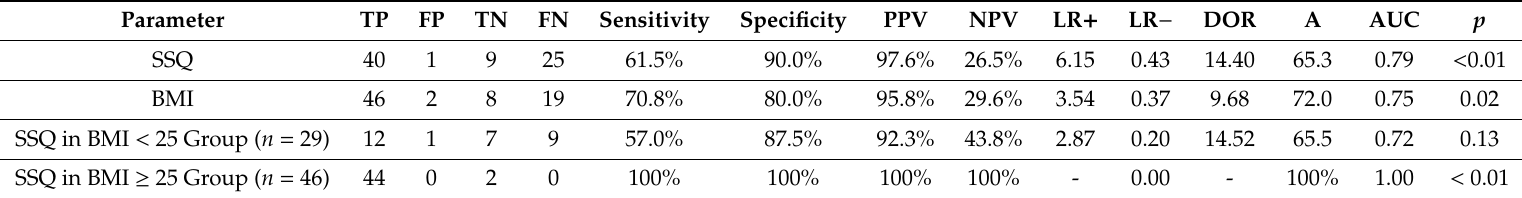
Table 2. Performance characteristics of the SSQ and the BMI in predicting high dietary salt intake, as determined by 24-h urine Na ≥ 100 mmol / day. Parameter TP FP TN FN Sensitivity